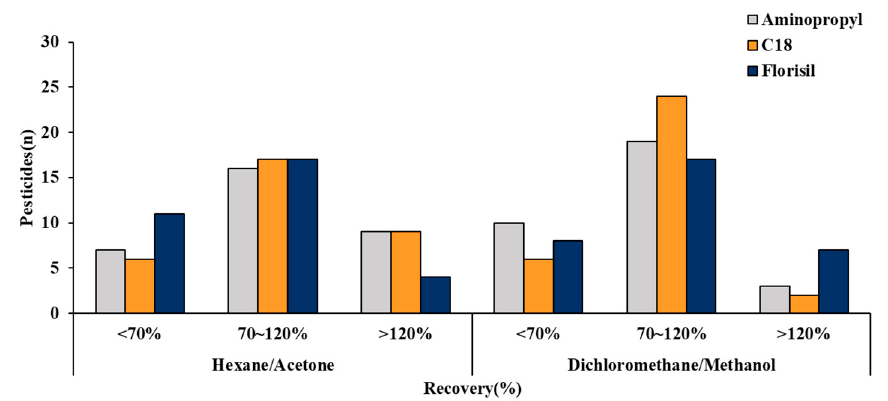
Figure 2. Comparison of recoveries for the 32 compounds obtained using three different SPE sorbents and two elution solvents.